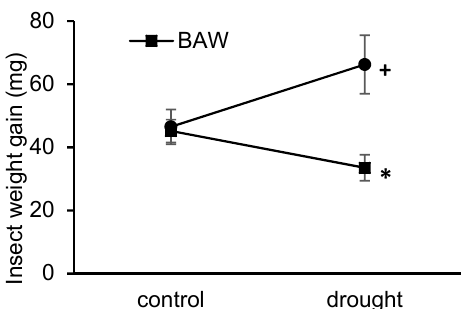
Figure 1. Effects of water availability on insect performance on Solanum dulcamara plants. Spodoptera exigua (beet armyworm, or BAW; squares) and Leptinotarsa decemlineata (Colorado potato beetle, or CPB; dots) larvae were fed for five days on well-watered (control) or drought-treated (drought) plants. + p < 0.10 and * p < 0.05 obtained from Student’s t tests for the effect of watering treatments on CPB and BAW weight gain, respectively. Error bars are standard errors, n = 12 per treatment combination.